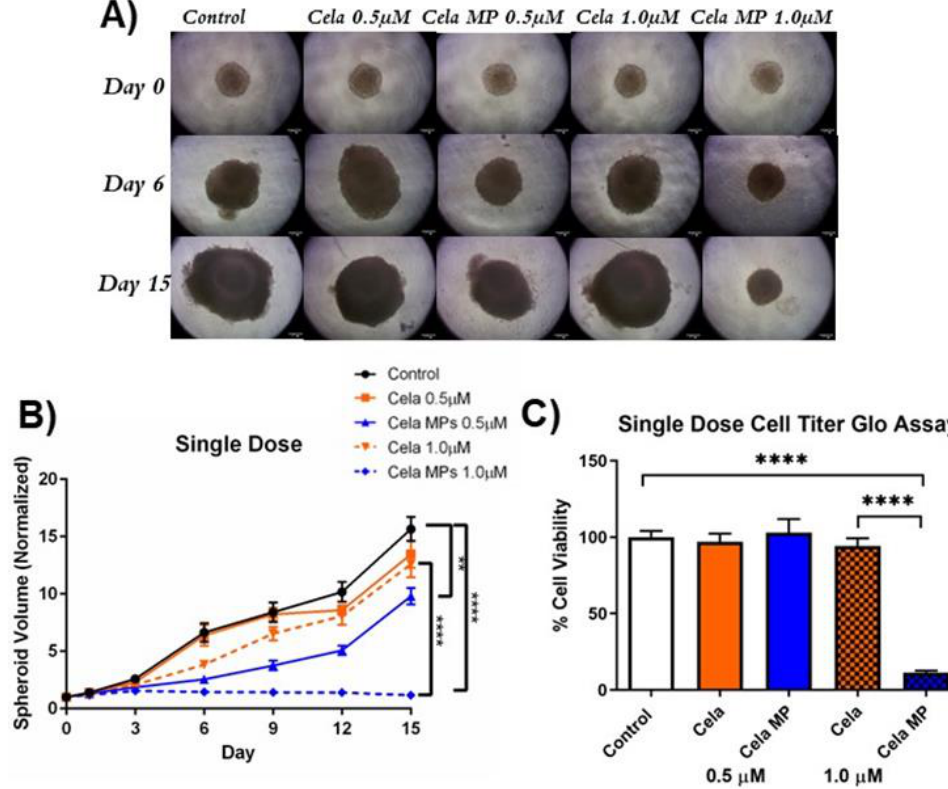
Figure 7. Single-dose 3D spheroid assay to determine the effects of treatment on MSTO-211H tumor spheroid growth. ( A ). Representative images of single-dose study taken at 10X magnification of spheroids on days 0, 3, 9, and 15. Scale bar represent 500 µm. ( B ). Quantification of spheroid volume (normalized to day 0 spheroid volume) over 15 days for single-dose study. Data represent mean ± SEM (n = 8). ( C ). Single-dose 3D cell viability study was performed using CellTiter ® Assay. Data represent mean ± SD (n = 4). Significance between groups was analyzed by one-way ANOVA and Tukey’s multiple comparisons test. ** p < 0.01 and **** p < 0.0001.